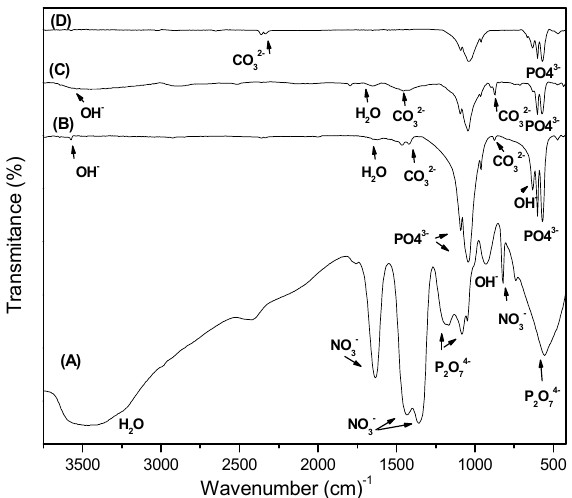
Figure 2. FTIR spectra of as-prepared powders ( A ) and thermally treated at different temperatures; 600 °C/2 h ( B ), 800 °C/2 h ( C ) and 1200 °C/2 h ( D ).